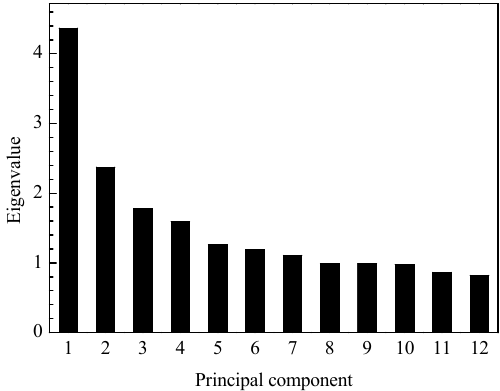
Figure 5. The principal component eigenvalues of fault 4.